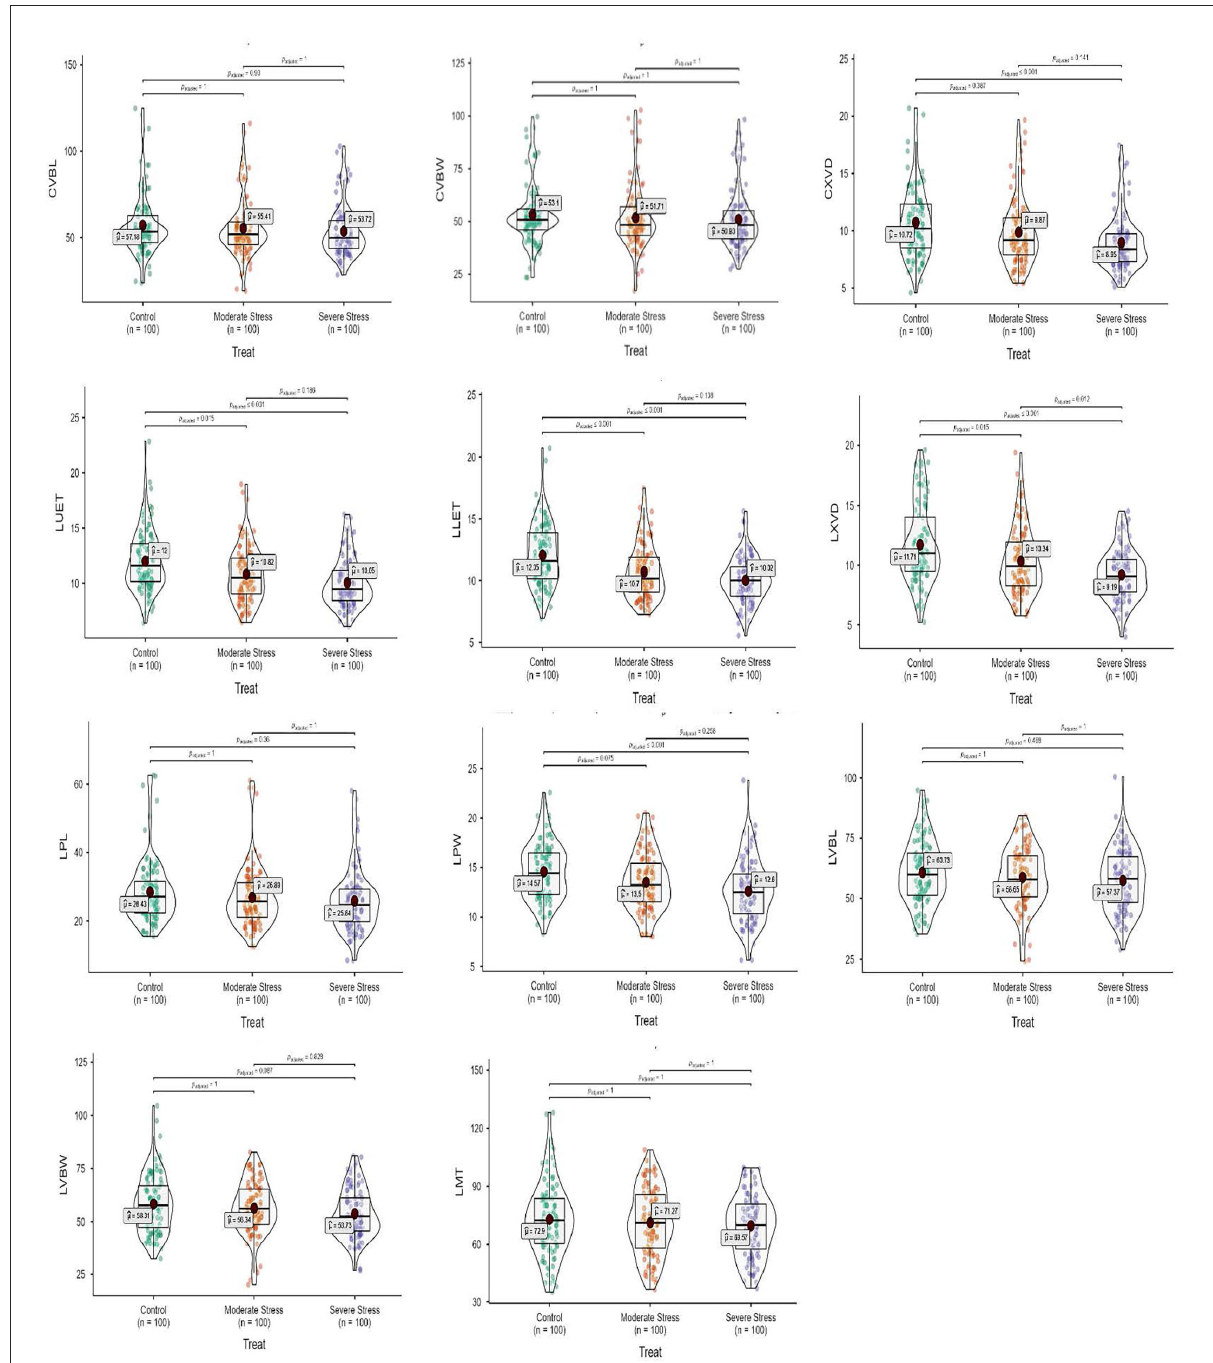
FIGURE3 Box-violin plots presenting culm and leaf anatomical features under control (C), moderate (MS), and severe (SS) water stress conditions. The interquartile range is depicted by the length of the boxes, the median by the horizontal line within the box, the mean by the red diamonds within the box, and the probability density of the data at different values by the widths of the violin plots.